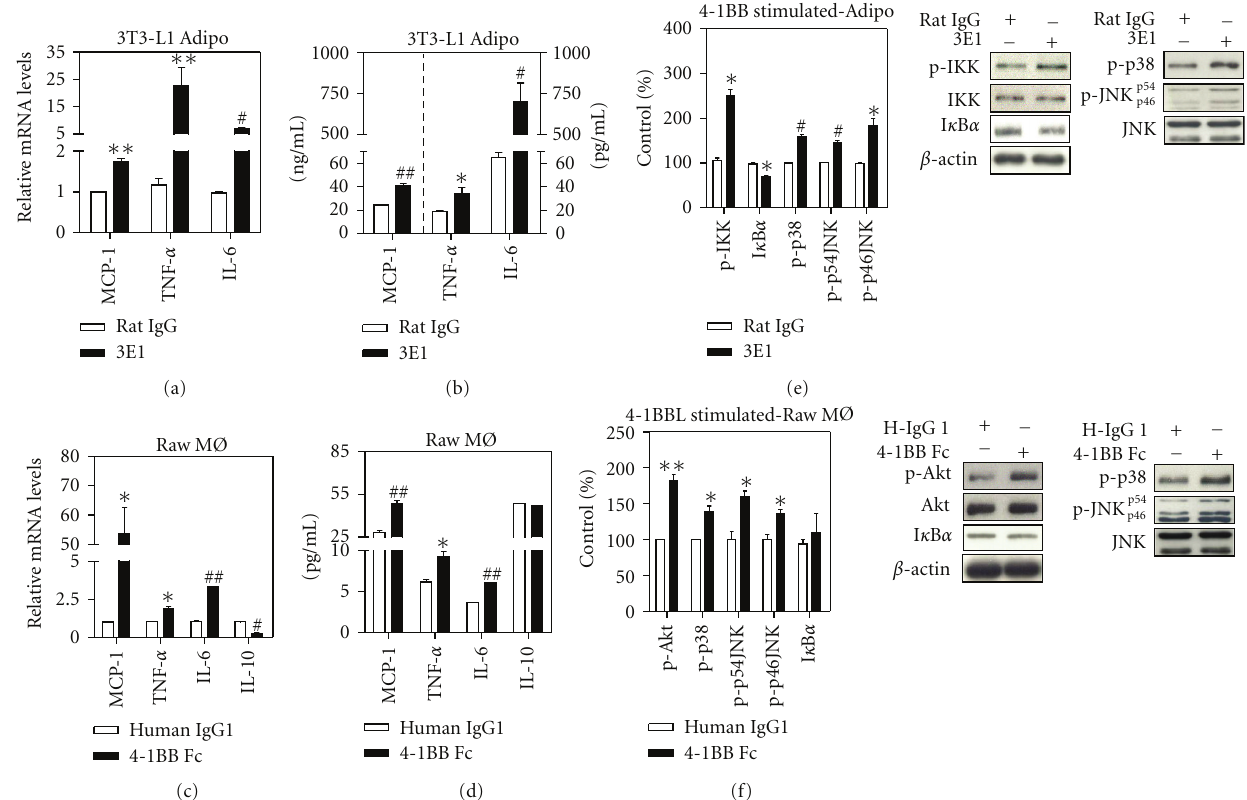
Figure 2: 4-1BB or 4-1BBL stimulation enhances release of various inflammatory cytokines from adipocytes or macrophages. 3T3-L1 adipocytes and Raw264.7 macrophages were treated with 1 μ g/mL 3E1 and 100 ng/mL r4-1BB Fc, respectively, for 48–24 h. MCP-1, TNF- α , IL-6, and IL-10 transcripts and proteins were then measured in the 3T3-L1 adipocytes (a-b) and Raw264.7 macrophages (c-d). The phosphorylation of IKK α / β (p-IKK α / β )/IKK β , I κ B α , p-p38, p-JNK/JNK, pAkt/Akt and β -actin were measured by western blotting. 3T3- L1 adipocytes were incubated with 1 μ g/mL 3E1 for 3h (e), and Raw264.7 macrophages with 100 ng/mL r4-1BB Fc for 1h (f). Results of densitometry were showed as percentage of control. Data are the mean ± SEM of three independent experiments performed in duplicate. ∗ P < 0 . 05; ∗∗ P < 0 . 01; # P < 0 . 005; ## P < 0 . 001 (compared with